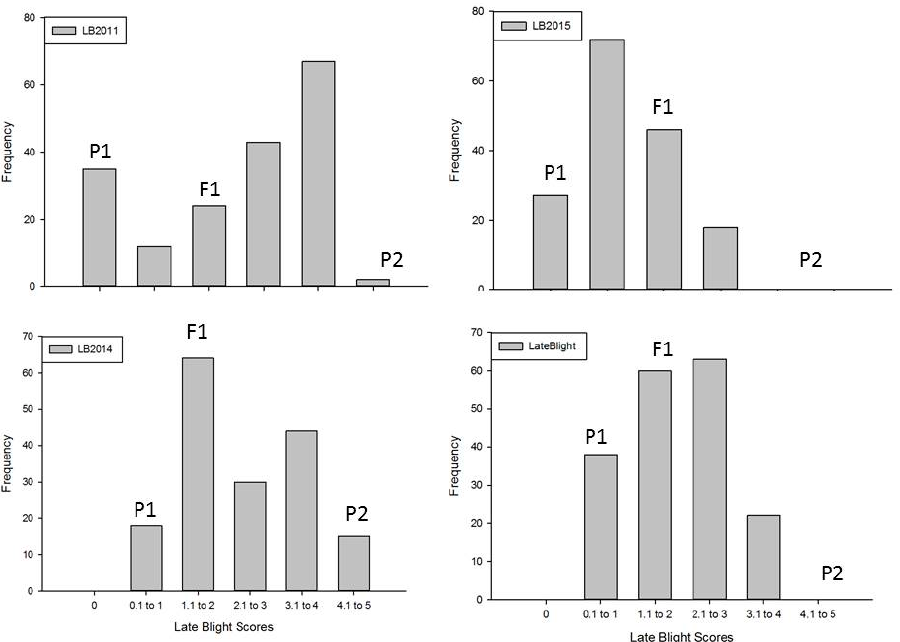
Figure 1. Frequency distribution of late blight resistance in NC10175 population evaluated at Mountain Horticultural Research & Extension Center (MHCREC) at Mills River, and Mountain Research Station (MRS) at Waynesville, North Carolina in 2011, 2014, and 2015. The figure shows the late blight distribution pattern in individual experiment, as well as in the summary data (Late Blight) from each year. In the figure, P1 = NC 1CELBR, P2 = Fla. 7775, and F1 = NC10175.